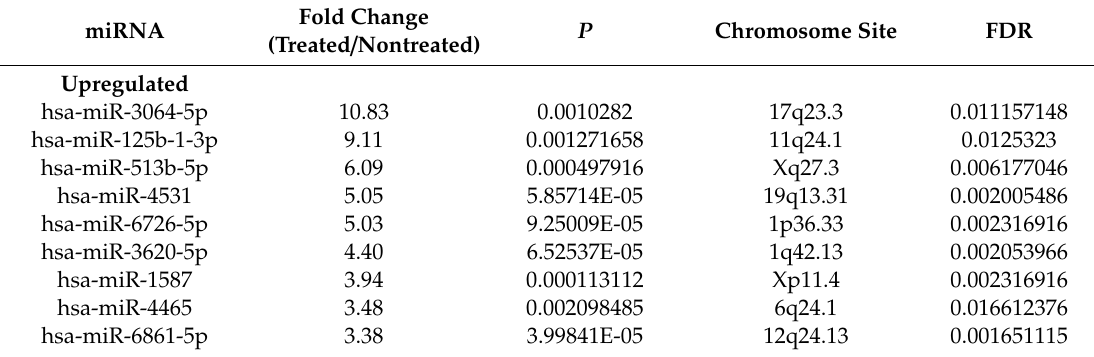
Table 1. Statistical results and chromosomal location of miRNAs in KYSE180 cells treated with telmisartan or untreated.